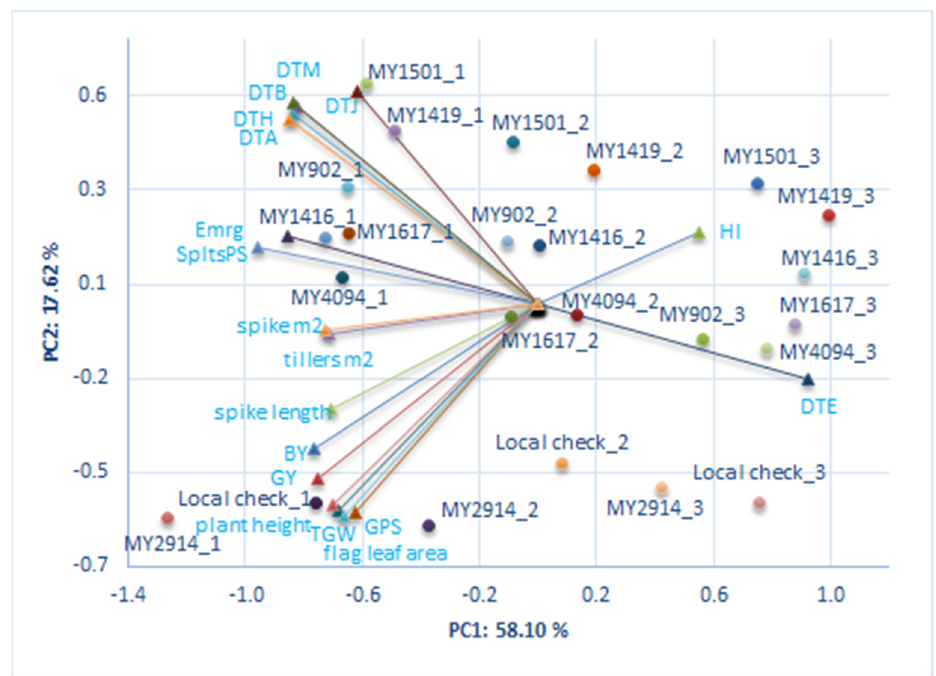
Figure 2. Bi-plot (PCA) presenting the correlation between the studied traits of different wheat gen- otypes sowing from normal to late planting. DTE = days to emergence, DTJ = days to jointing, DTB = days to booting, DTH = days to heading, DTA = days to anthesis, DTPM = days to physiological